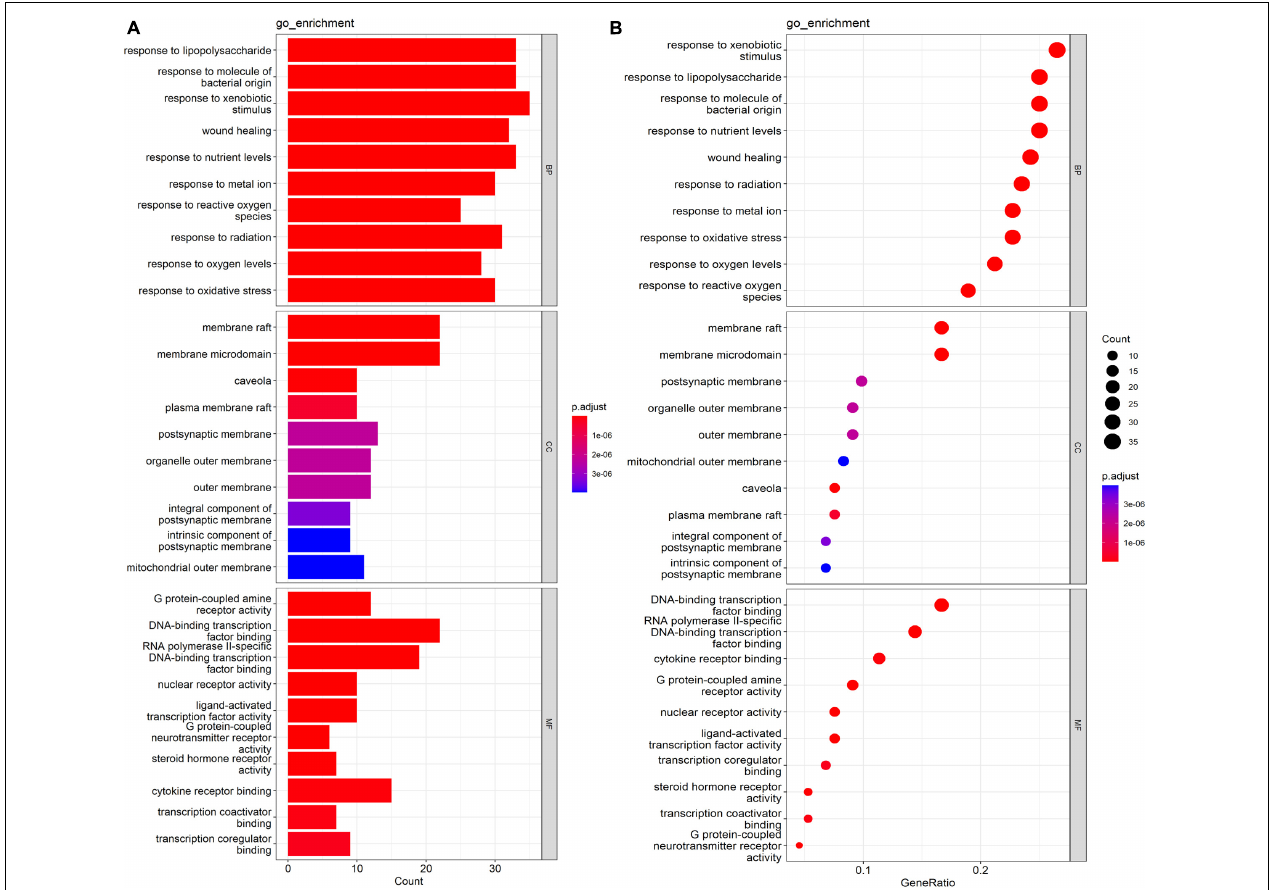
FIGURE 4 | GO enrichment analysis of intersection genes. (A) Barplot. (B) Dotplot.